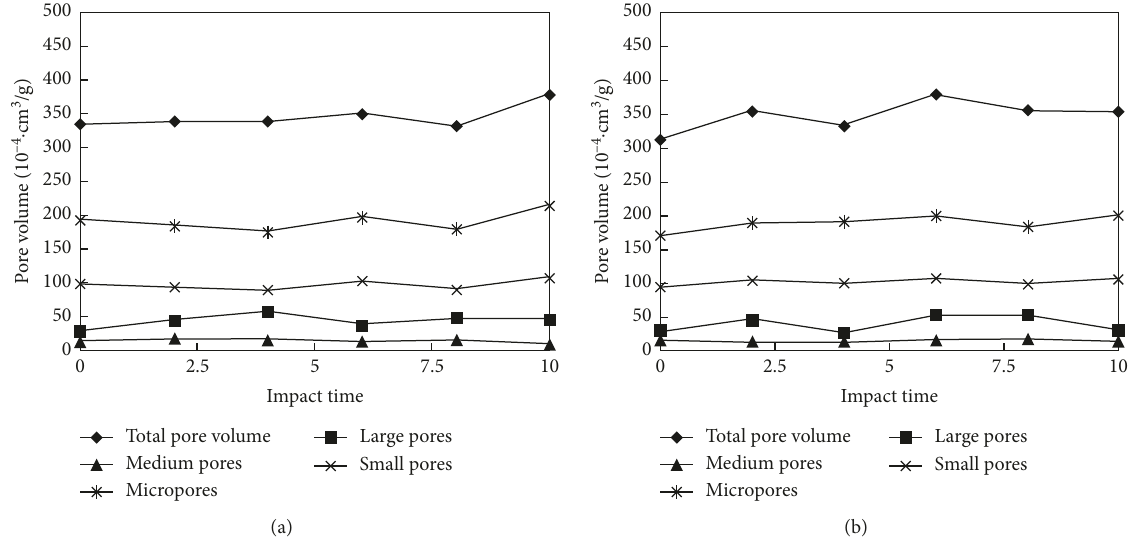
Figure 6: Plots of pore volume to shock times for fat coal samples: (a) 5 g energetic projectiles; (b) 10 g energetic